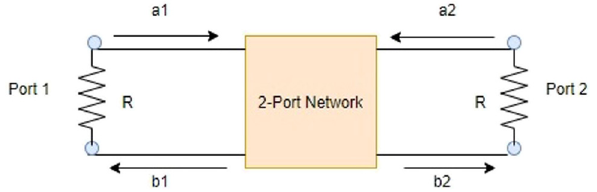
Figure 5: Two - port